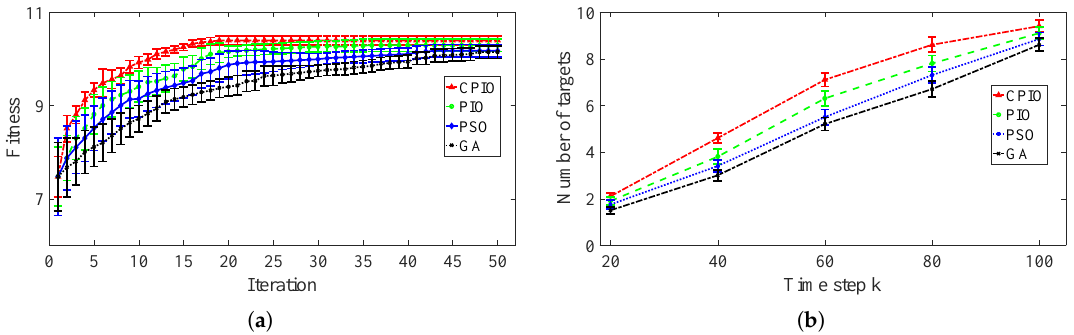
Figure 8. Search performance of CPIO, PIO, PSO, and GA: ( a ) Convergence speed; ( b ) Average number of targets found